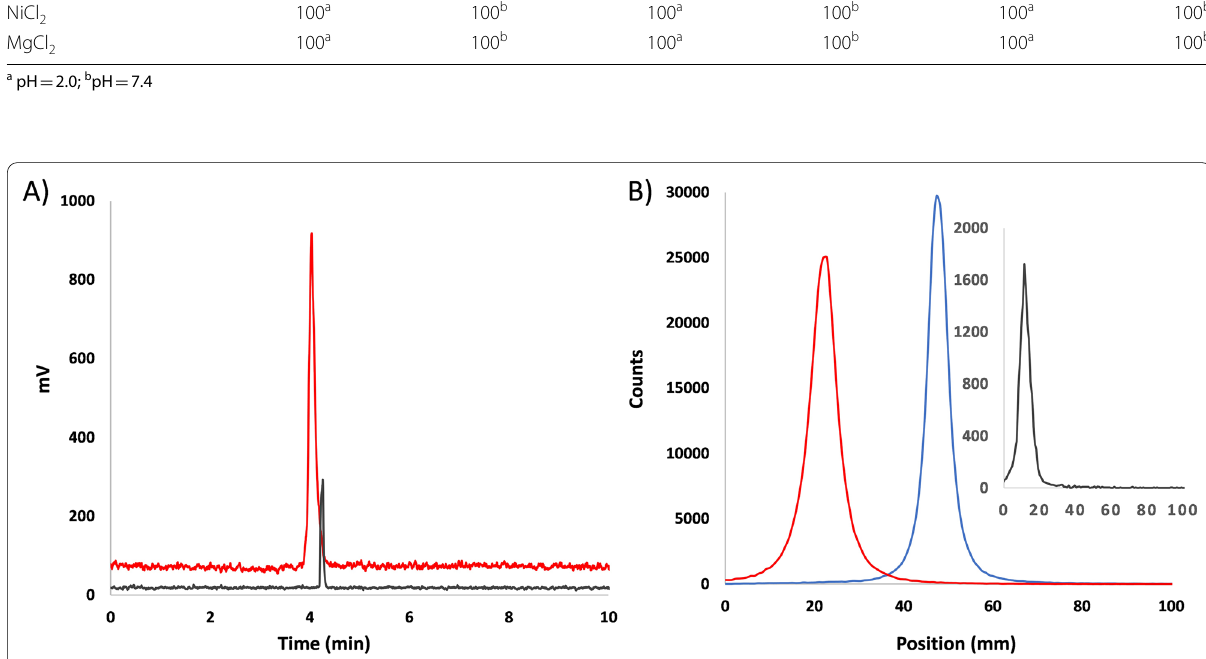
Fig. 6 Representative radio‑UPLC and iTLC profiles of A pure [ 68 Ga]Ga‑4HMSA (red line) and [ 68 Ga]Ga‑4HMSA in the supernatant fraction after 2 h incubation in human plasma (grey line); B [ 68 Ga]GaCl 3 (blue line), pure [ 68 Ga]Ga‑4HMSA (red line) and in the insert, [ 68 Ga]Ga‑4HMSA in the supernatant fraction after 1 h in rodent (grey line)